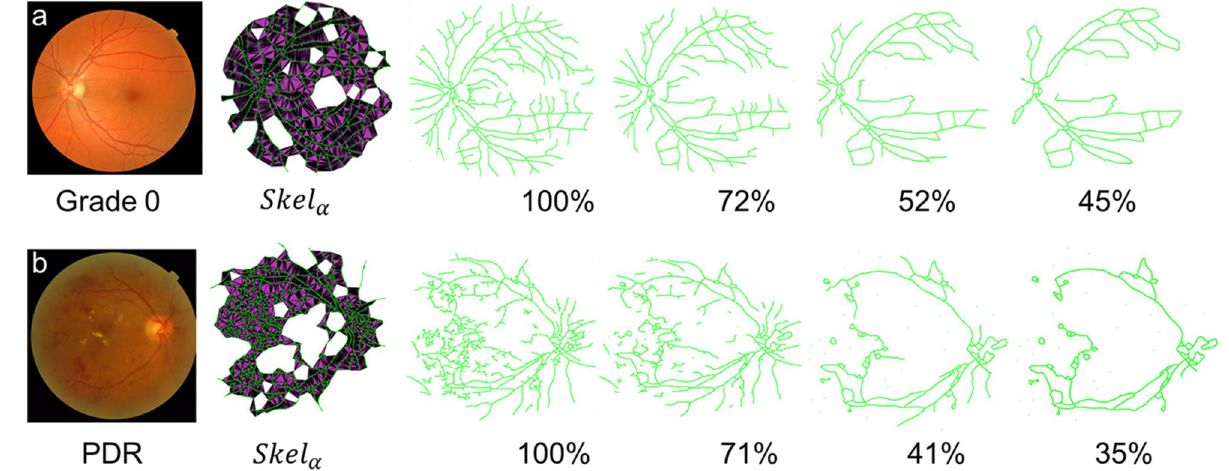
Figure 2. Example of vessel degradation using incremental morphological erosion. ( a) Fundus image from a healthy participant (Grade 0, no PDR) and Skel α overlaid onto the skeleton obtained from 13 . The skeleton contains erroneous segmentations that are iteratively removed resulting in a skeleton 45% of the original skeleton. ( b) Fundus image from PDR case and Skel α overlaid onto the skeleton obtained from 13 . Image is eroded to 35% of the original skeleton removing many of the minor blood vessels.